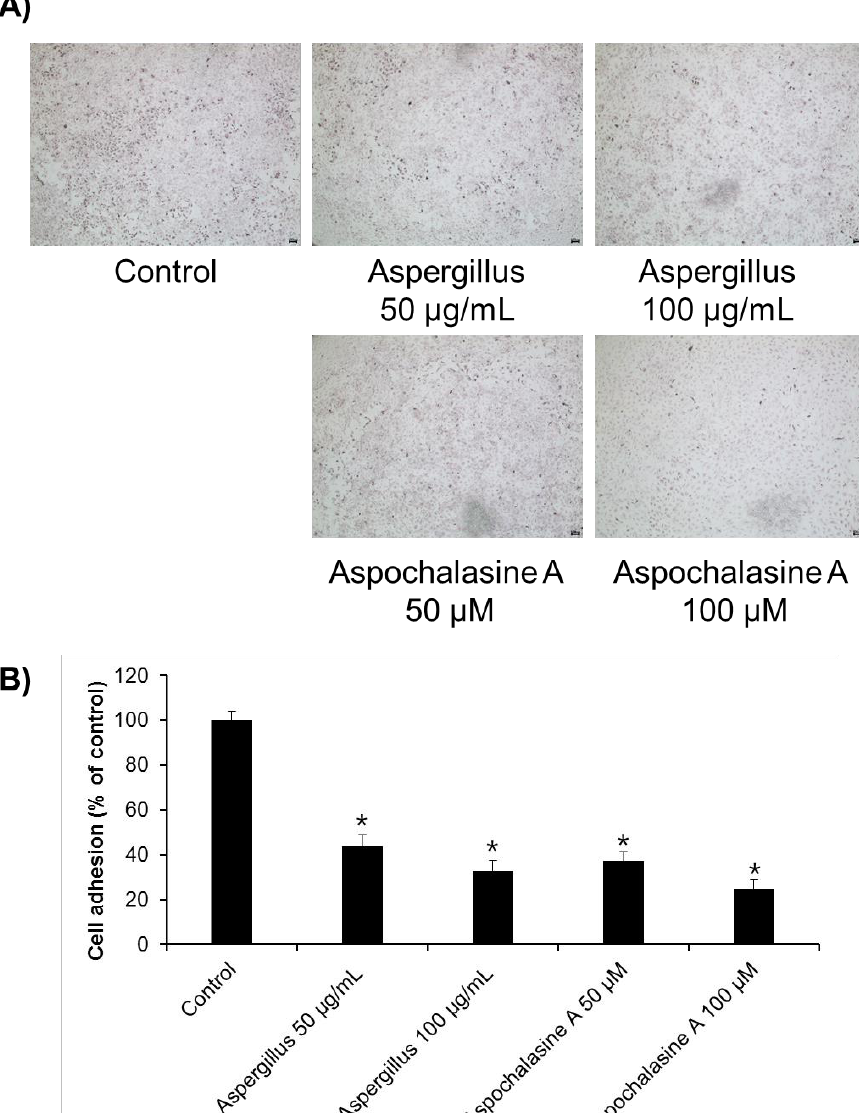
Figure 2. The effect of Aspergillus extract and aspochalasine A on HUVECs adhesion. HUVECs were treated with test samples ( Aspergillus extract and aspochalasine A) or the DMSO vehicle (control) for 30 min. Cells that underwent adhesion were ( A ) imaged and ( B ) counted. Data are expressed as mean ± SEM. Similar results were obtained in three independent experiments; * p < 0.05 compared to the control value.